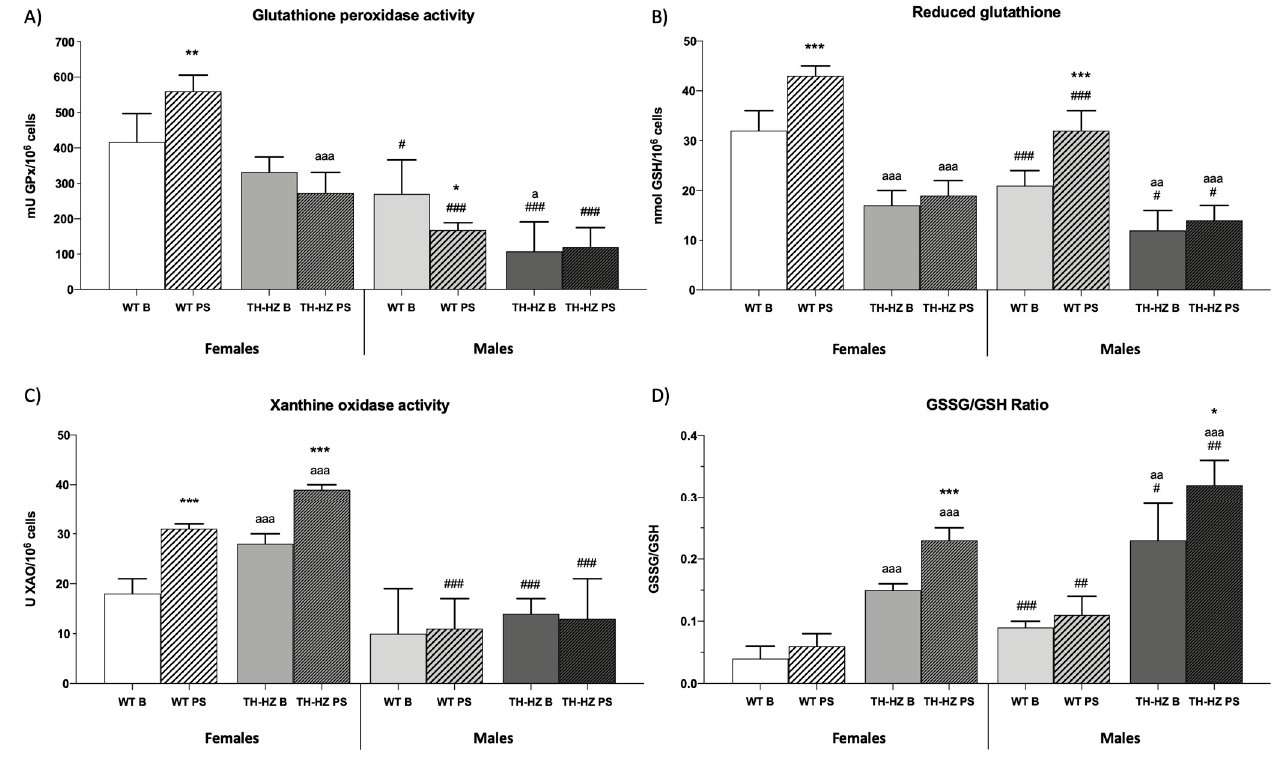
Figure 5. Oxidative stress parameters. ( A ) Glutathione peroxidase activity (mU GPx/10 6 cells). ( B ) Reduced glutathione levels (nmol GSH/10 6 cells). ( C ) Xantine oxidase activity (U XO/10 6 cells) ( D ) GSSG/GSH ratio. Each column represents the mean ± standard deviation of values corresponding to 6 animals. * p < 0.05, ** p < 0.01, *** p < 0.001 compared to basal condition, a p < 0.05, aa p < 0.01, aaa p < 0.001 compared to WT. # p < 0.05, ## p < 0.01, ### p < 0.001 compared to female. WT B: Wild type basal. WT PS: Wild type post-stress. TH-HZ B: TH-HZ basal. TH-HZ PS: TH-HZ post-stress.